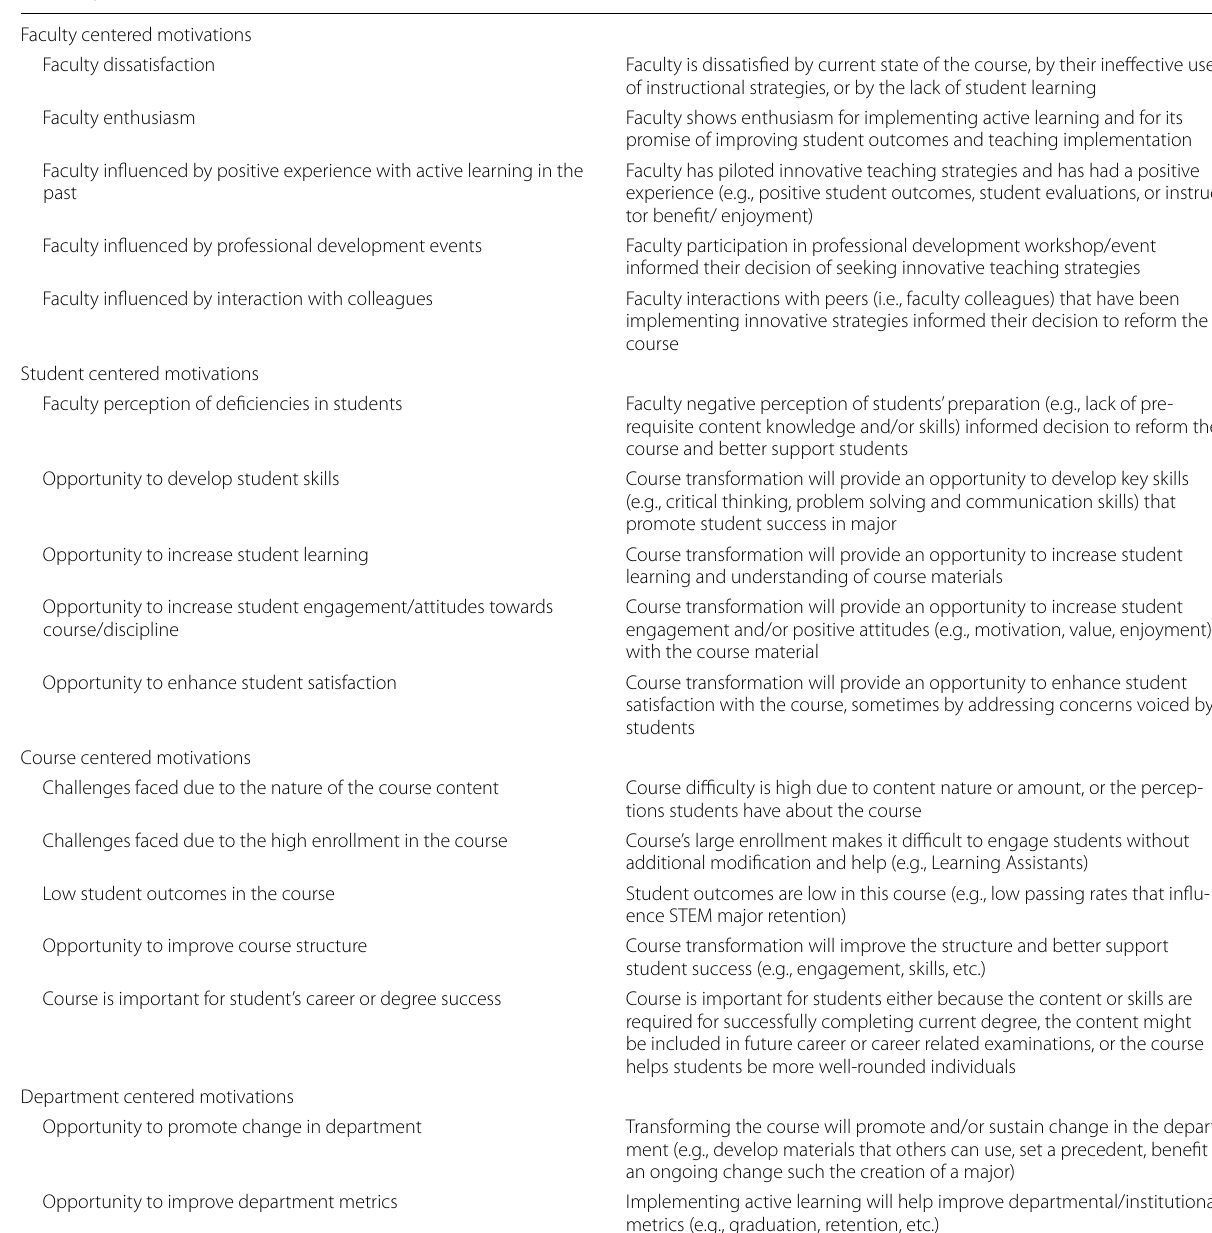
Table 2 Summary of qualitative themes of Faculty Scholar’s motivation to transform their course (at application stage)